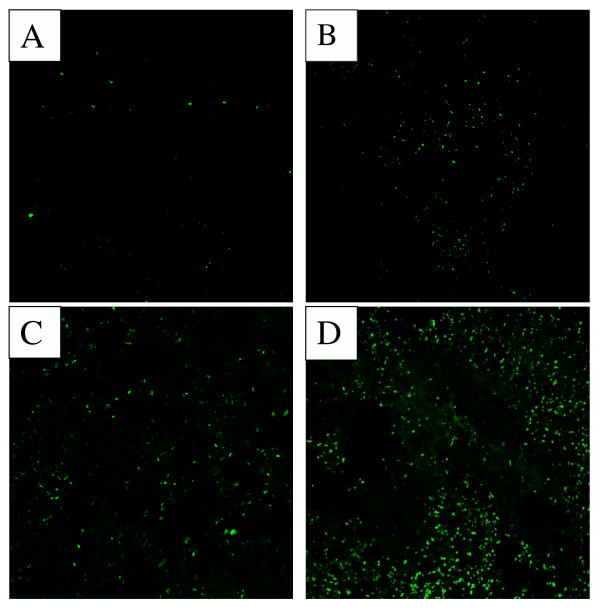
Representative images for apoptosis (TUNEL) in the following protocols: aerobic control (A); 30, 90 and 180 minutes of simulated ischaemia followed by 120 minutes of reoxygenation (B, C and D, respectively).